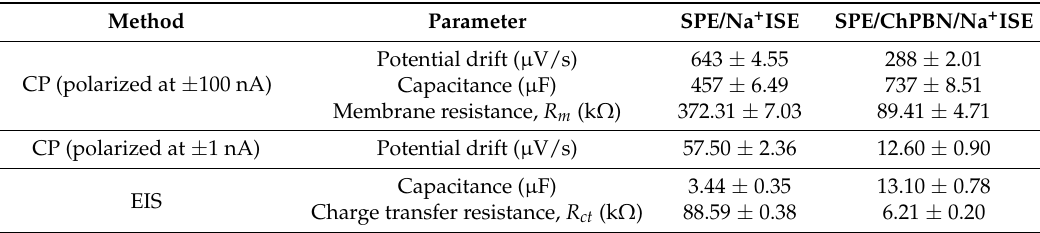
Table 2. Capacitance and interfacial resistance values obtained by chronopotentiometry (CP) and electrochemical impedance spectroscopy (EIS) from the SPE/ChPBN/Na + ISE and SPE/Na + ISE